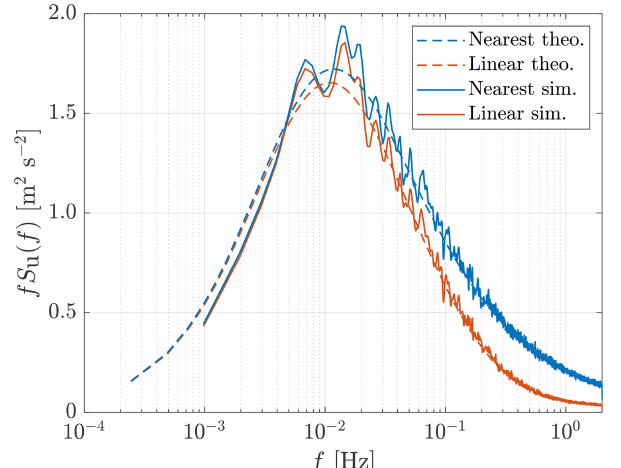
Figure 9. Comparison of the impact of nearest-neighbor interpola- tion and linear interpolation on the auto-spectrum of the u compo- nent. A 2-by-2 square grid on the yz plane with a width of 5m is considered, and the point to be interpolated is the center point of the square grid. The auto-spectra are averaged with 16